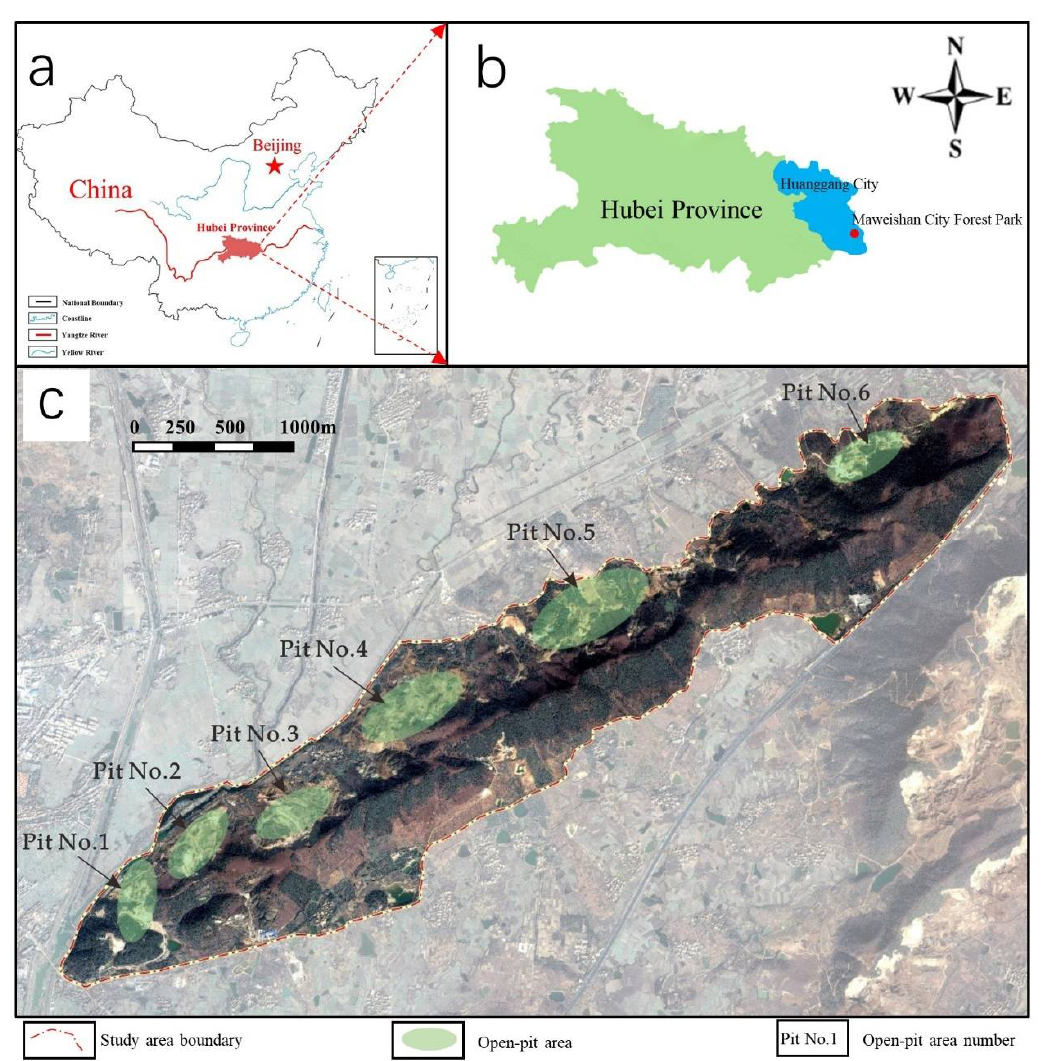
Figure 1. Overall location map and distribution map of Mawei Mountain iron ore pits. ( a ) The position of Hubei Province in China. ( b ) The location of Maweishan City Forest Park in Hubei Province. ( c ) Research Areas of Mawei Mountain iron ore pits.